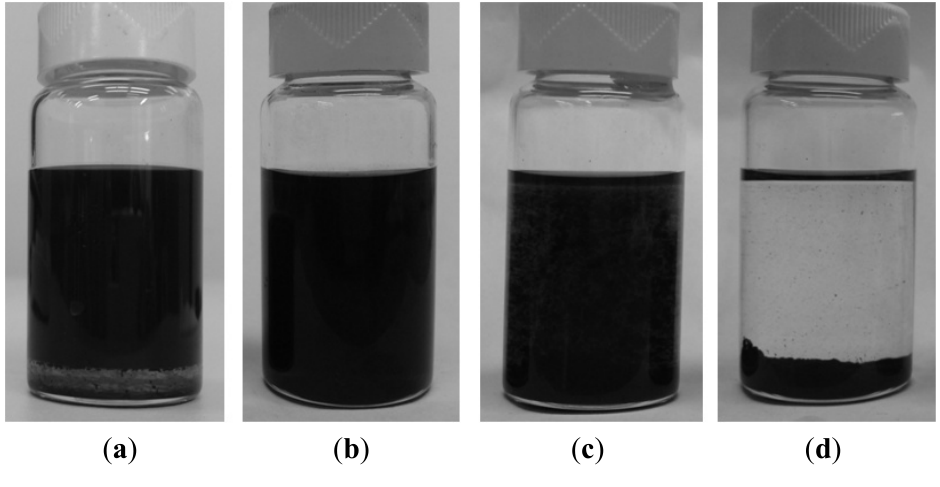
Figure 3. Vial images showing effect of poly(dimethylsiloxane) (PDMS) on dispersion state of MWCNTs in THF solution: ( a ) PDMS added into dispersed MWCNTs-THF solution; ( b ) THF solution containing PDMS and MWCNTs directly after 30 min of sonication; ( c ) solution at 30 min after completion of sonication, showing visible CNTs bundles, and ( d ) solution at 21 h after sonication, showing complete phase separation which indicated the instability of